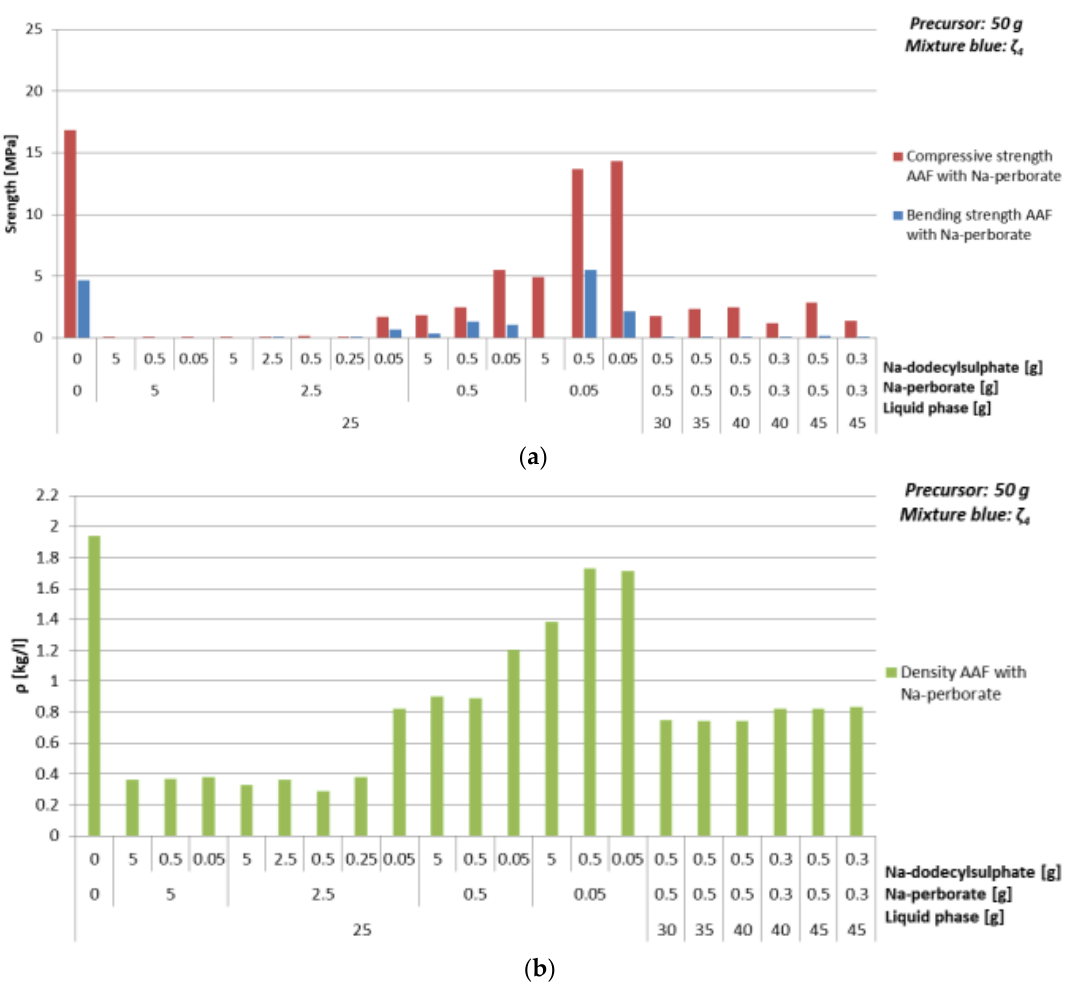
Figure 15. ( a ) Bending and compressive strength, and ( b ) density of AAF, produced by Na-perborate using mixture ζ 4 , cured on 70 °C for one day, measured one week after molding. Table 17. Density, bending, and compressive strength of AAF, produced by Na-perborate using mixture ζ 0 , cured on 70 °C for one day, measured one week after molding. Combination of ingredients for AA resulting in literature’s highest compressive strength value is coloured .